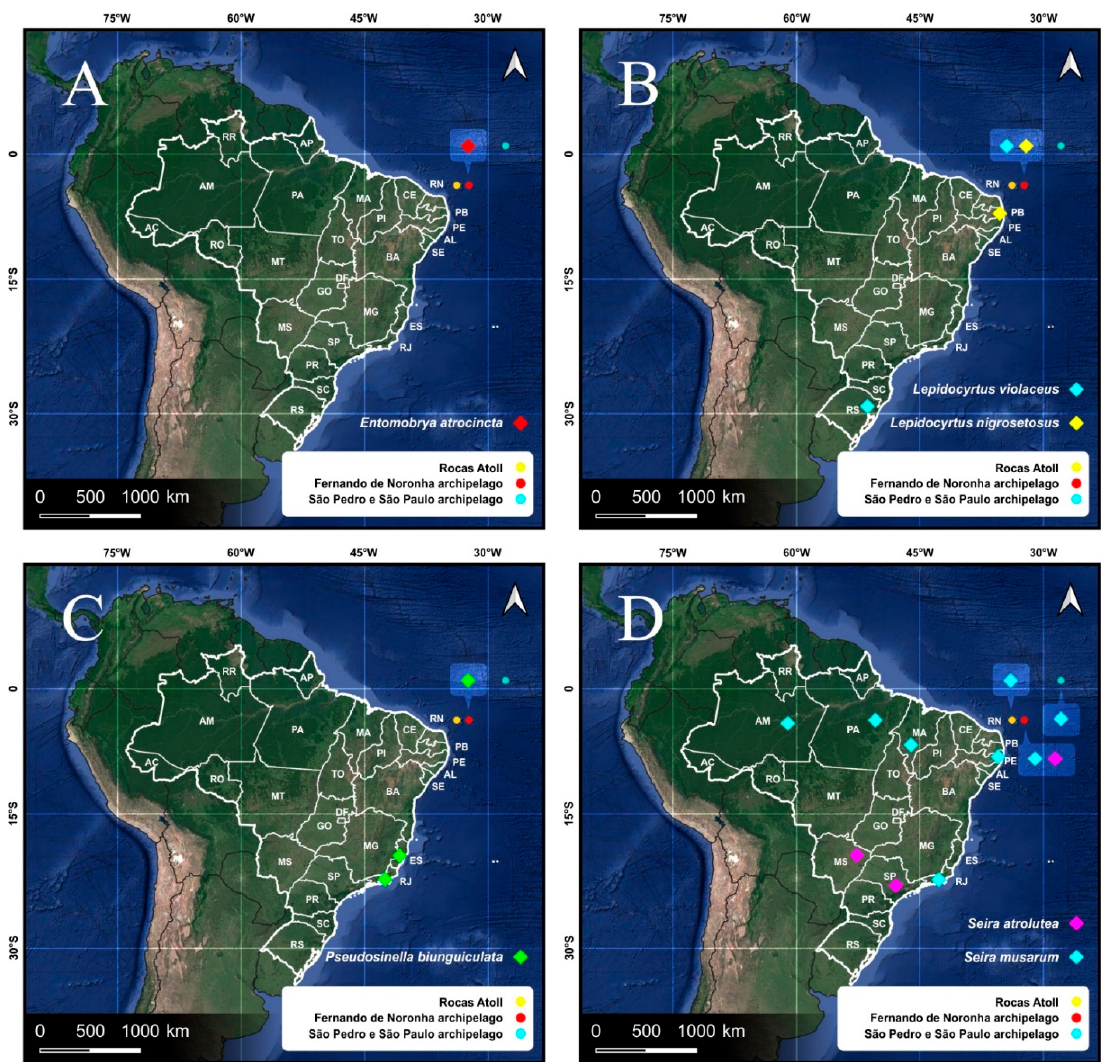
Figure 5. Distribution map for Entomobryidae records in Brazil mainland and oceanic islands. ( A ). Entomobrya atrocincta ; ( B ). Lepidocyrtus violaceus and L. nigrosetosus ; ( C ). Pseudosinella biunguiculata ; ( D ). Seira atrolutea and Seira musarum .